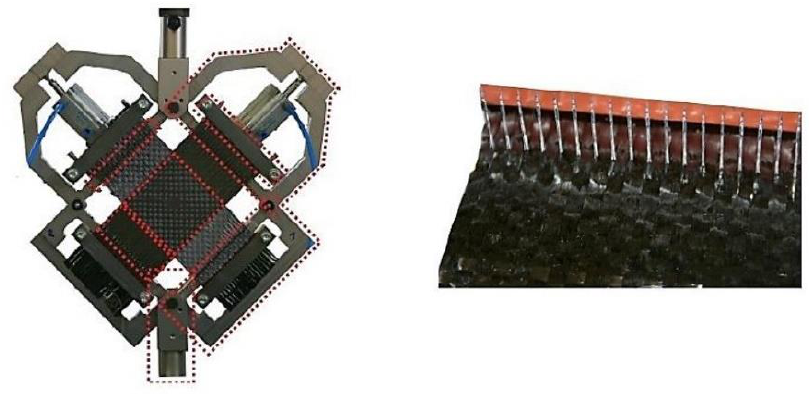
Figure 8. Biaxial tension and shear test on a plain-woven carbon fabric [22]. Table 1. Geometric information of the T700-12K carbon fiber plain-woven fabric specimen [22]. Specimen